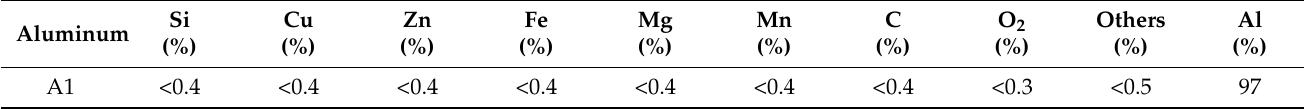
Table 1. Chemical composition of the aluminum of the test